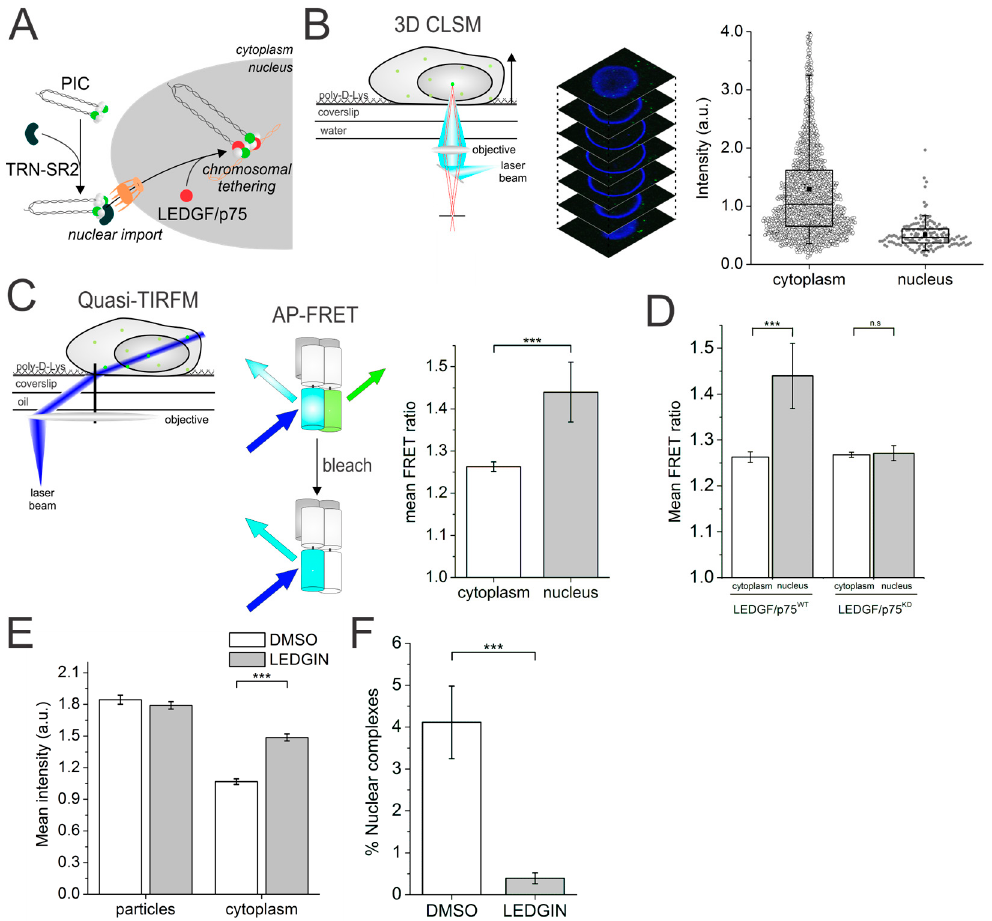
Figure 3. ( A ) Cartoon of the cellular cofactors TRN-SR2 and LEDGF/p75 involved in nuclear import and pre-integration complex (PIC) tethering to the host genome; ( B ) (left) 3D confocal imaging of cells infected with fluorescently labeled viral particles (Right) Fluorescence intensity of HIV IN-eGFP complexes in infected cells in the cytoplasm (black circles) and nucleus (grey circles); ( C ) (left) Quasi-TIRFM imaging of HIV IN-mTFP1+IN-mVenus in infected cells enables acceptor photobleaching FRET measurements. (Right) Mean FRET ratio of HIV IN-mTFP1+IN-mVenus complexes in the cytoplasm and nucleus of infected HeLaP4 cells obtained using acceptor photobleaching FRET and quasi-TIRFM; ( D ) Mean FRET ratio of HIV IN-mTFP1+IN-mVenus in the cytoplasm (white) and nucleus (grey) in wild-type HeLaP4 infected cells and LEDGF/p75 depleted cells showing no increase in nuclear FRET signal in the latter; ( E ) Mean fluorescence intensity of viral particles and viral complexes localized in the cytoplasm of infected cells produced in the presence of DMSO (white) and LEDGINs (grey); ( F ) Percentage of nuclear complexes in cells infected with viral particles produced in the presence of DMSO (white) or LEDGINs (grey). (C-F) *** = p -value<0.001 and n.s.=not significant, as obtained from an unpaired